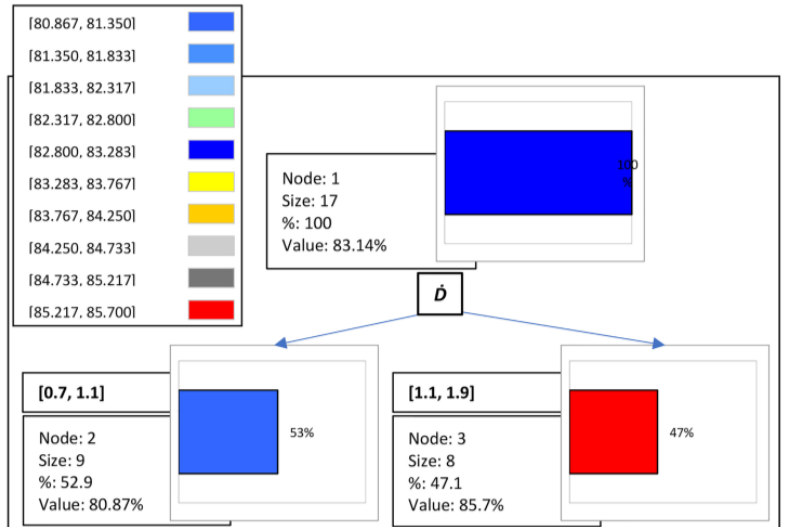
Figure 7. Regression tree: decision making for FM . Table 14. Rules in decision tree for FM .